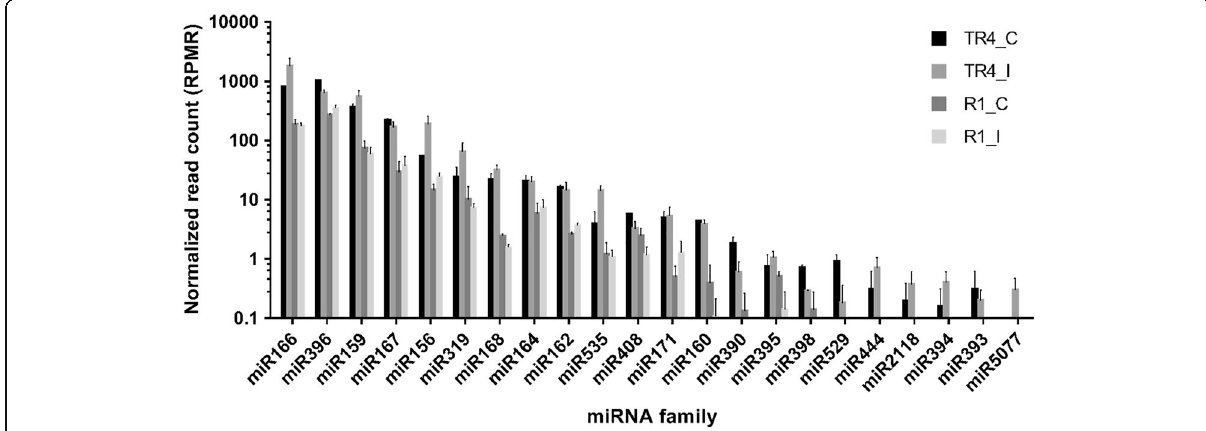
Fig. 2 MiR166, miR396 and miR159 possessed the highest expression in the treatment groups. The miRNA families listed on the X-axis are the identified miRNA families in the twelve sRNA libraries. The normalized read count on the Y-axis was calculated as “ reads per million reads ” (RPMR) for each sRNA library. The logarithmic scale was used to display the normalized read count. Error Bars represent Standard Error of the Mean